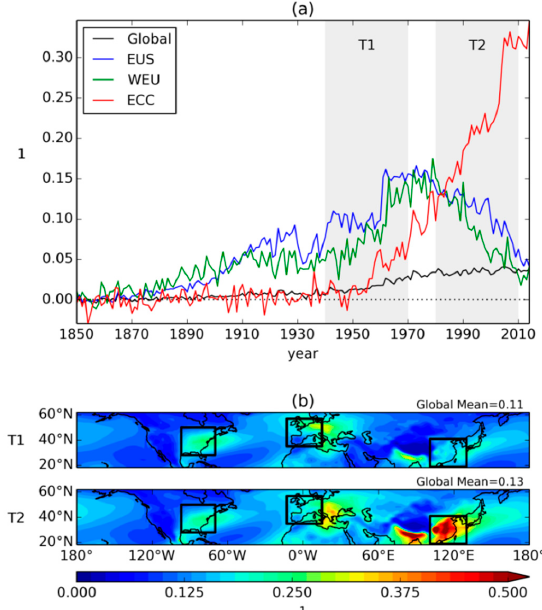
Figure 2. ( a ) Timeseries of global and regional mean change in aerosol optical depth ( δ AOD) at 550 nm over the historical period (1850–2014) relative to pre-industrial (PI) (1850) levels with grey shade indicating analysis periods T1 (1940–1970) and T2 (1980–2010), and ( b ) the spatial distribution of the 550 nm AOD. Each box indicates Eastern United States (EUS), Western European Union (WEU), and Eastern Central China (ECC) region.